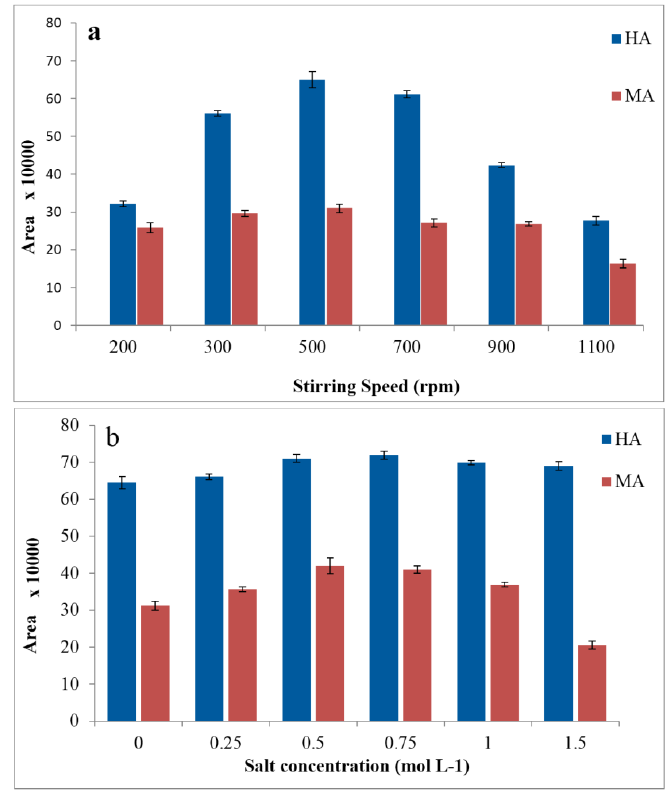
Figure 3. Effects of stirring speed ( a ) and salinity ( b ) on extraction efficiency of HA and MA by HF-LPME. Extraction conditions: 10 mL aqueous sample solution of 1 mg · L − 1 metabolites